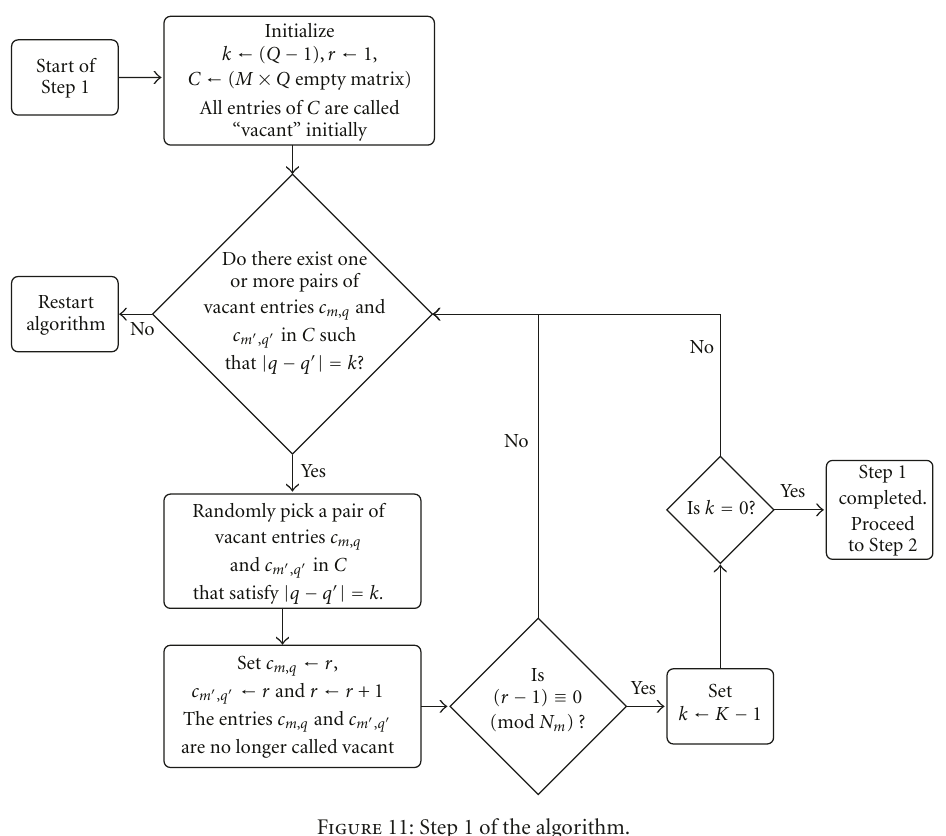
Figure 11: Step 1 of the algorithm.